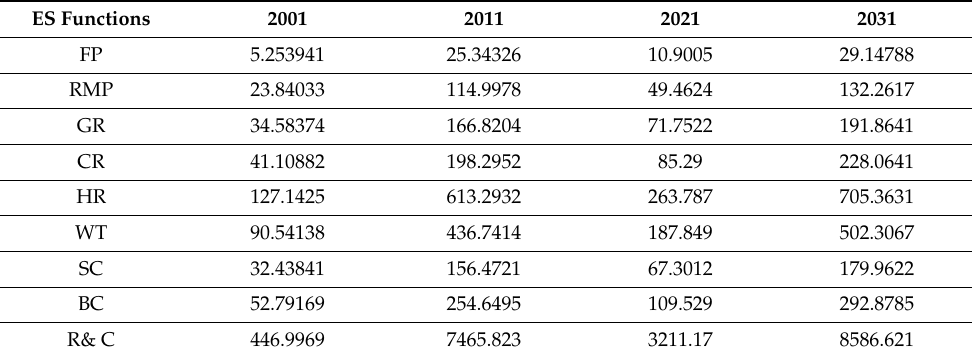
Table 12. The changes in the values of different ES functions in Damietta Governorate during